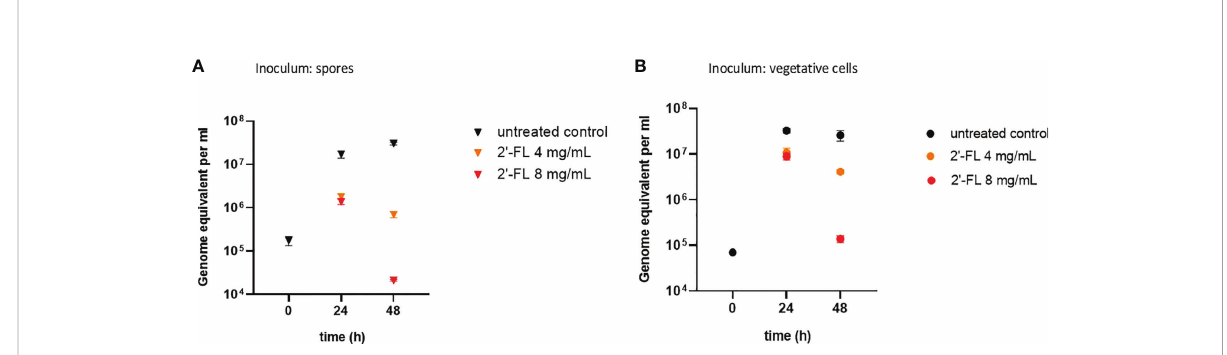
FIGURE 1 2'-FL inhibits proliferation of C. dif fi cile in the CDi-screen model (panel A Inoculum: spore, panel B Inoculum: vegetative cells). Detection of C. dif fi cile within a complex microbiota in the CDi-screen using C. dif fi cile -speci fi c 16S qPCR at t=0 and 24 h and 48 h, in the absence of 2 ’ -FL (untreated control, black symbol), and media supplemented with 2 ’ -FL at 4 mg/mL (orange symbol) and 8 mg/mL (red symbol). Data are plotted as genome equivalents per mL, derived from standard